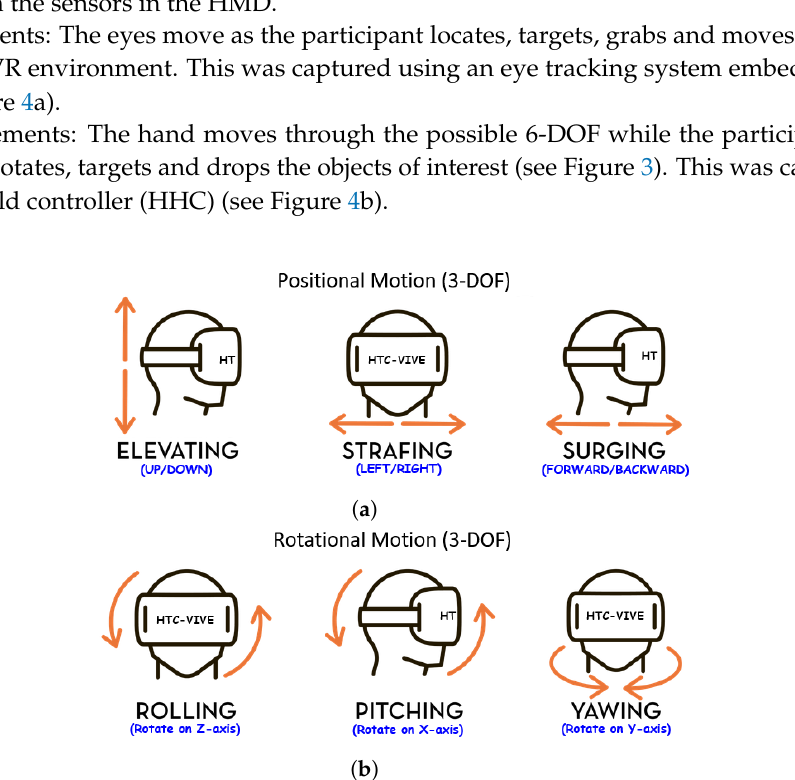
Figure 3. Possible 6-DOF VR Movements. ( a ) [Positional Motion] is the location of the object in the 3D world space. There are three possible positions motions (3-DOF). (i) Elevation is where the head/hand moves up or down (i.e., when bending down or standing up) . (ii) Strafe is where the head/hand moves left or right (i.e., sidestepping) . (iii) Surge is where the head/hand moves forwards or backwards (i.e., when walking) . ( b ) [Rotational Motion] is the orientation of the object in 3D world space. There are three possible orientations (3-DOF). (i) Roll is where the head/hand pivots side to side (i.e., peeking around a corner) . (ii) Pitch is where the head/hand tilts along a vertical axis (i.e., when looking up or down) . (iii) Yaw is where the head/hand swivels along a horizontal axis (i.e., looking left or right)